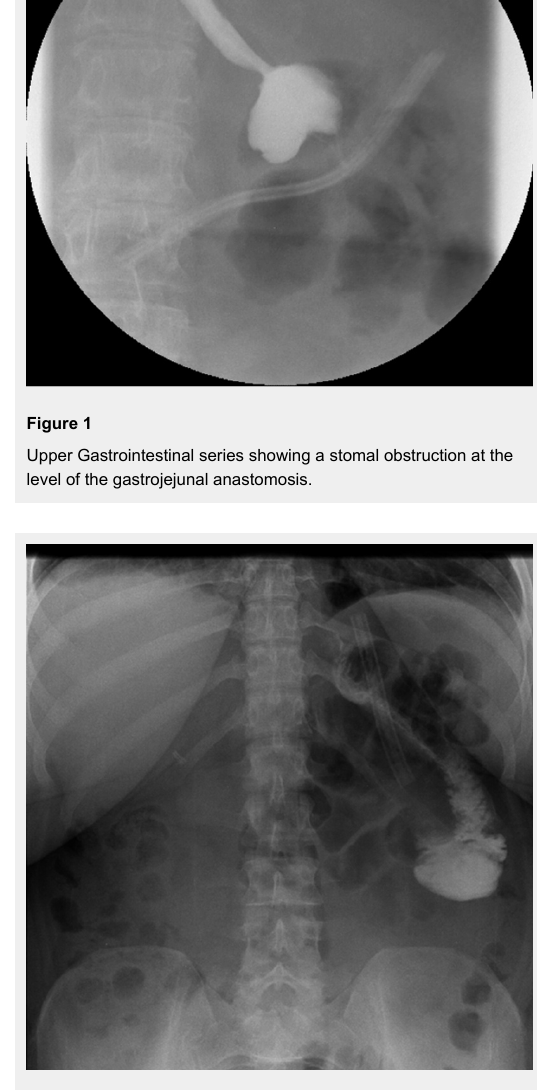
Figure 2 X-ray showing a stenosis at the level of the jejunojejunal